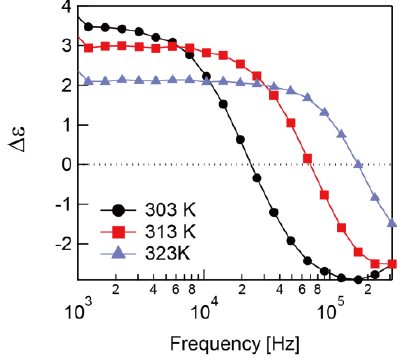
Figure 4. Frequency dependence of the dielectric anisotropy before polymerization.